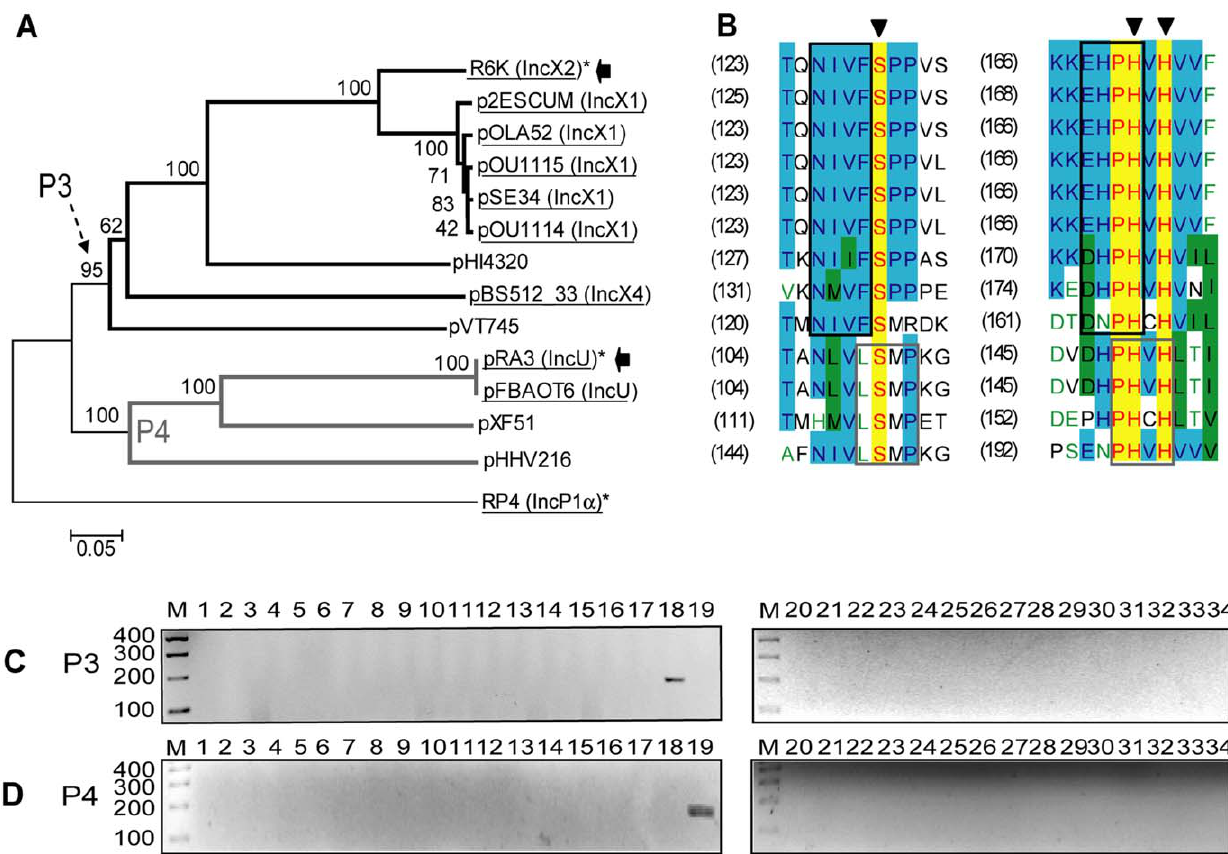
Figure 3. DPMT validation for MOB P3 and MOB P4 relaxases. A) Phylogenetic tree of MOB P3 and MOB P4 relaxase families. B) Alignment of the relaxase motifs used to design the MOB P3 and MOB P4 degenerate primers (P3-f + P3-r, continuous black; and P4-f + P4-r, continuous dark grey). C) Amplicons obtained with primers for subfamily MOB P31 (P3-f and P3-r). D) Amplicons obtained with primers for subfamily MOB P42 (P4-f and P4-r). Symbols, colour codes and lanes as in Figure 1.